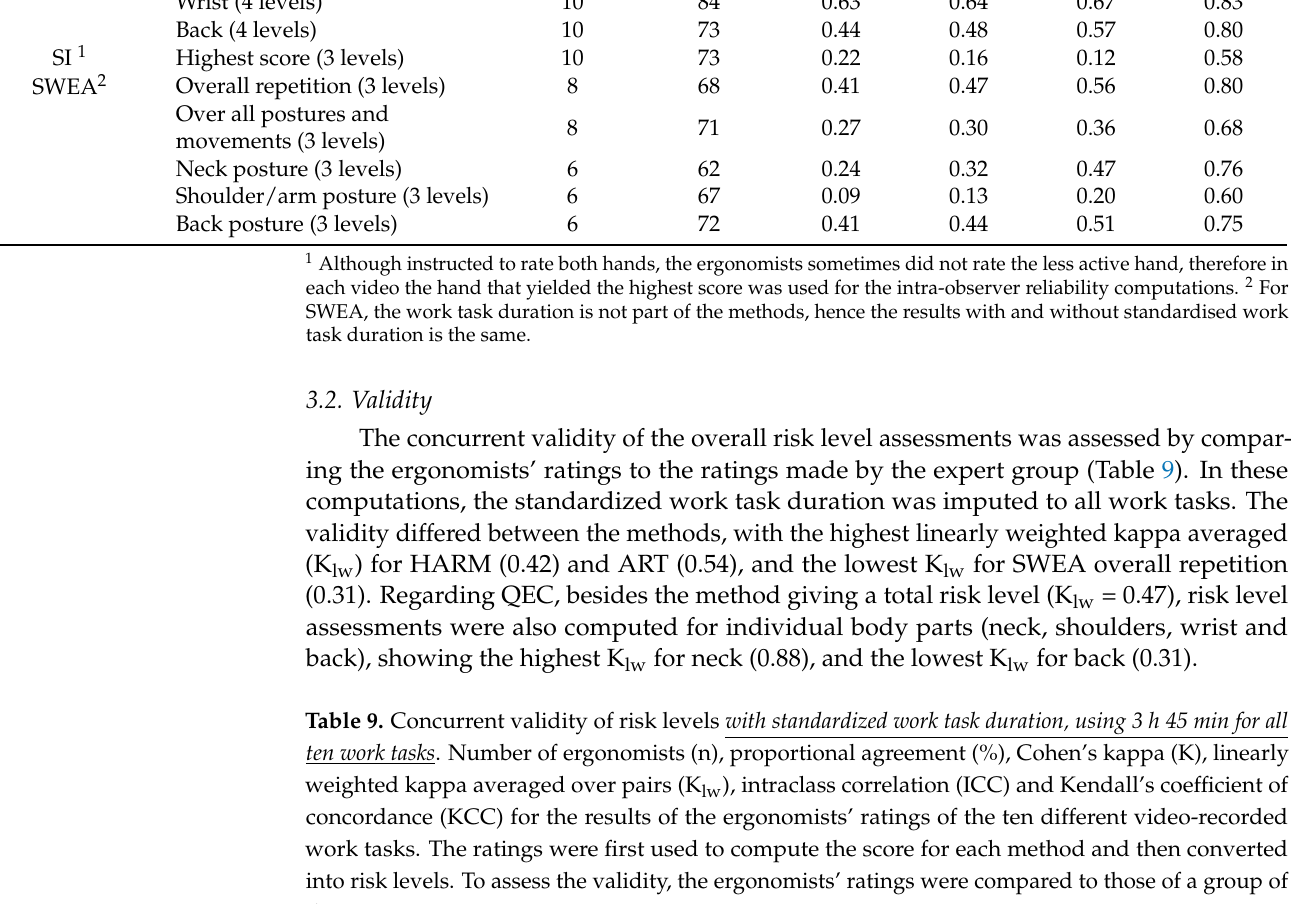
Table 9. Concurrent validity of risk levels with standardized work task duration, using 3 h 45 min for